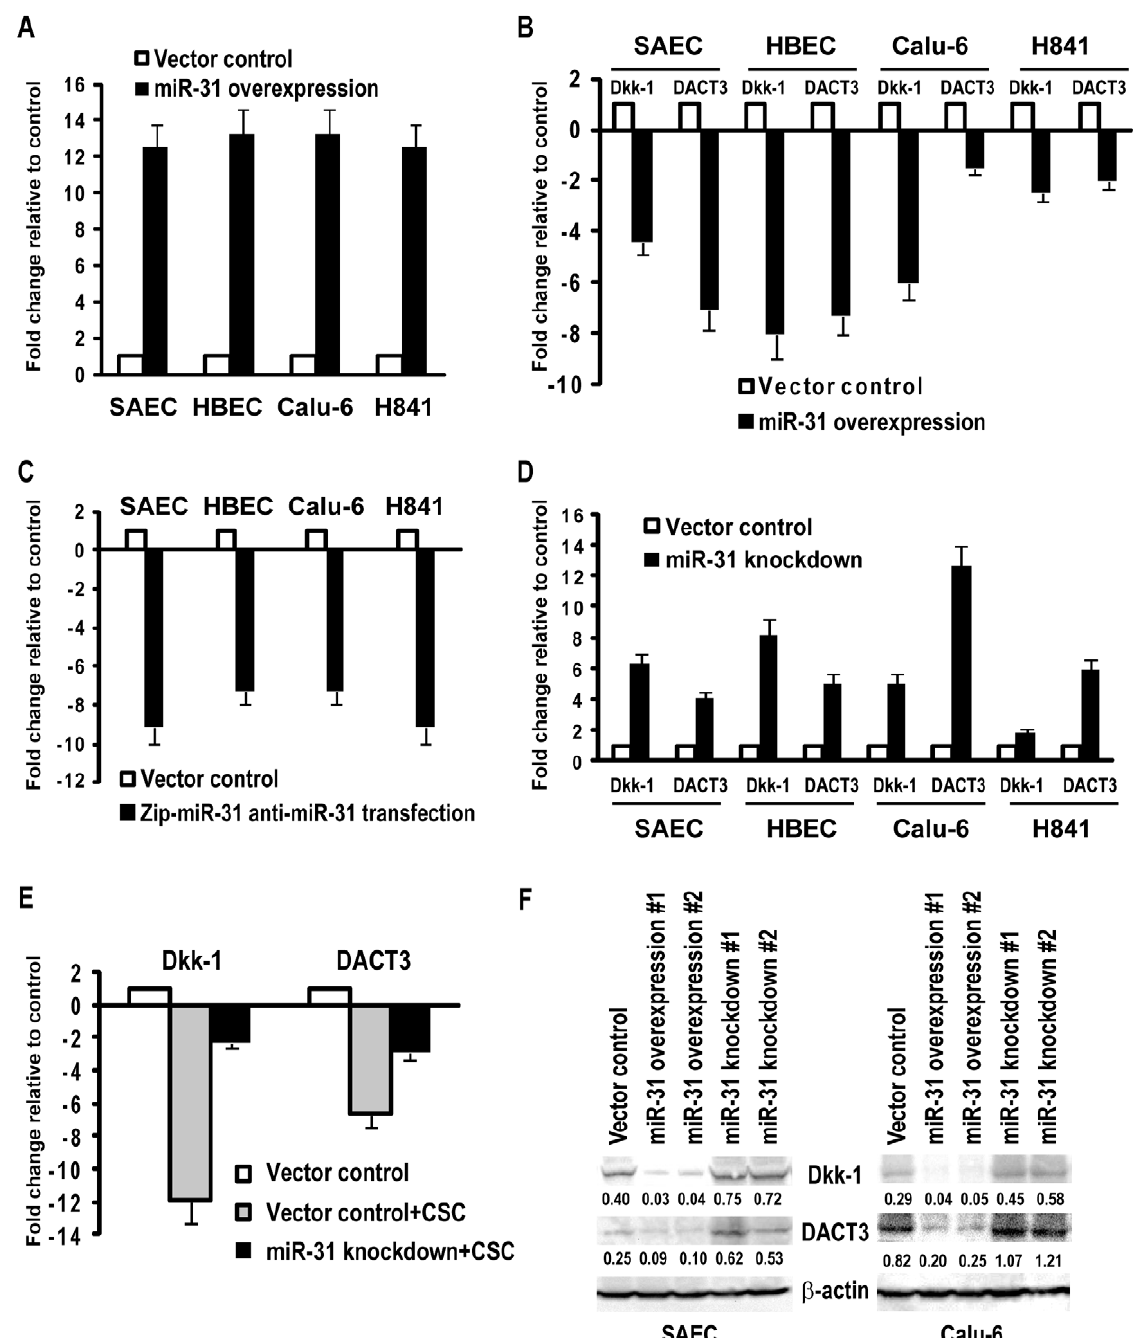
Figure 2. miR-31 negatively regulates WNT signaling pathway antagonists in normal respiratory epithelia and lung cancer cells. A) miR-31 was over-expressed in SAEC, HBEC, Calu-6, and H841 cells via transient transfection of primary miR-31 constructs. qRT-PCR analysis confirmed high level miR-31 expression in miR-31-transfected relative to control cells. B) qRT-PCR analysis of Dkk-1 and DACT3 expression levels in SAEC, HBEC, Calu-6, and H841 cells with or without over-expression of miR-31. Over-expression of miR-31 decreased Dkk-1 and DACT3 in all four cell lines. C) qRT- PCR analysis demonstrating decreased levels of endogenous miR-31 in SAEC, HBEC, Calu-6, and H841 cells following transient transfection of antisense-miR-31(Zip-miR-31) constructs relative to controls. D) qRT-PCR analysis of Dkk-1 and DACT3 expression levels in SAEC, HBEC, Calu-6 and H841 cells with or without down-regulation of miR-31. Knock-down of miR-31 enhances basal levels of Dkk-1 and DACT3 in these cells. E) qRT-PCR analysis demonstrating that knockdown of miR-31 partially blocks CSC-mediated decreases of Dkk-1 and DACT3 in SAEC. F) Western blot analysis of Dkk-1 and DACT3 expression in parental and vector control SAEC and Calu-6 cells, as well as SAEC and Calu-6 cells exhibiting constitutive over- expression or knock-down of miR-31. Densitometry values are normalized to b-actin control. Dkk-1 and DACT3 level were decreased, or somewhat enhanced in these cells following over-expression, or knock-down of miR-31, respectively.